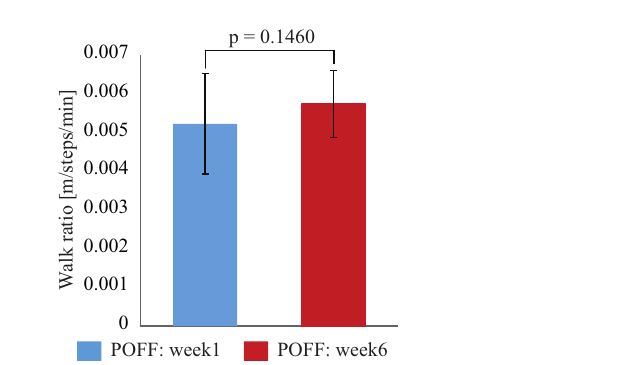
Figure 12. Comparison of the walk ratio achieved in the POFF condition between Week 1 and Week 6. On each bar chart, the error bar denotes one standard deviation.